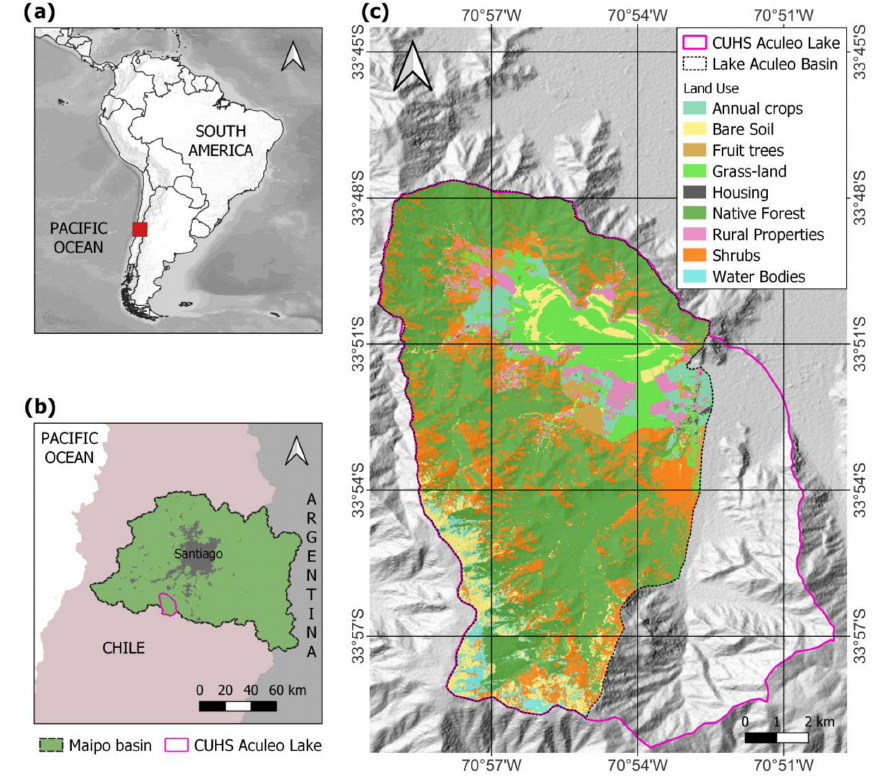
Figure 1. The Aculeo basin located in central Chile near the capital, Santiago (a, b) , and main land uses (c)